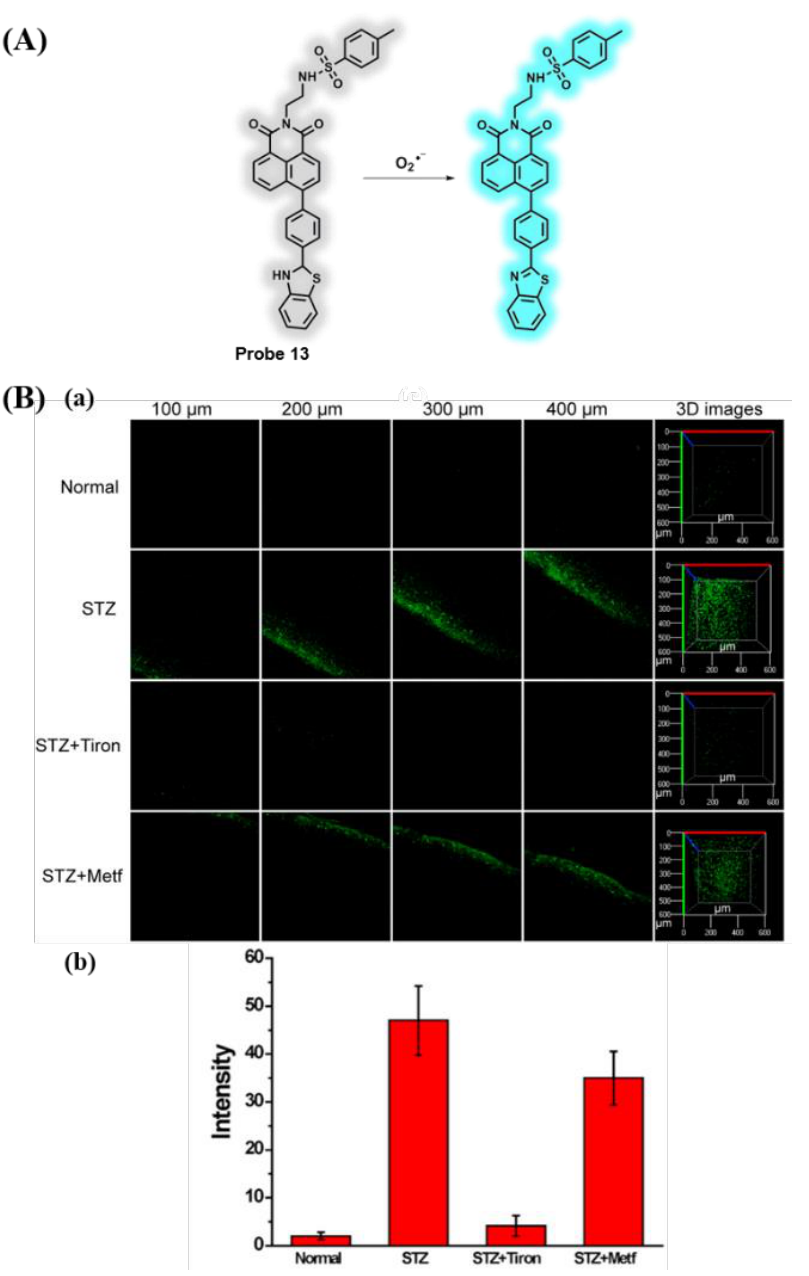
Figure 11. ( A ) Imaging mechanism of probe 13 ; ( Ba ) the two-photon fluorescence images at different depths, and the 3D stack images of liver tissue were stained with probe 13 (100 µ M, 50 µ L) under different treatments; ( Bb ) the fluorescence intensity statistics were output by selecting five represen- tative regions of ( Ba ). Conditions: λ ex = 750 nm, λ em = 420 − 480 nm. Adapted from Reference